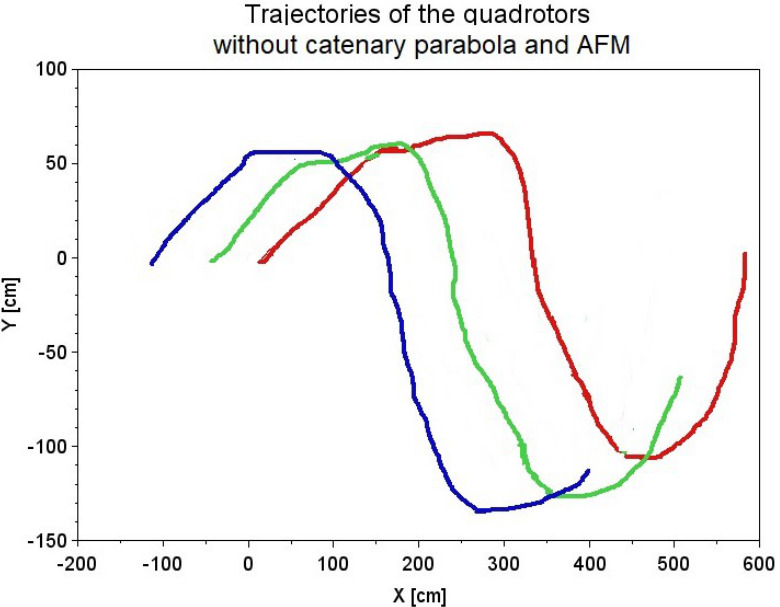
Figure 14. Trajectoriesof the quadrotors in Experiment 1 when neither the catenary-parabola approxi- mation nor the online AFM tuning of the PD controllers were applied. Color code: red, green and blue correspond to leader, mid and rear drones,